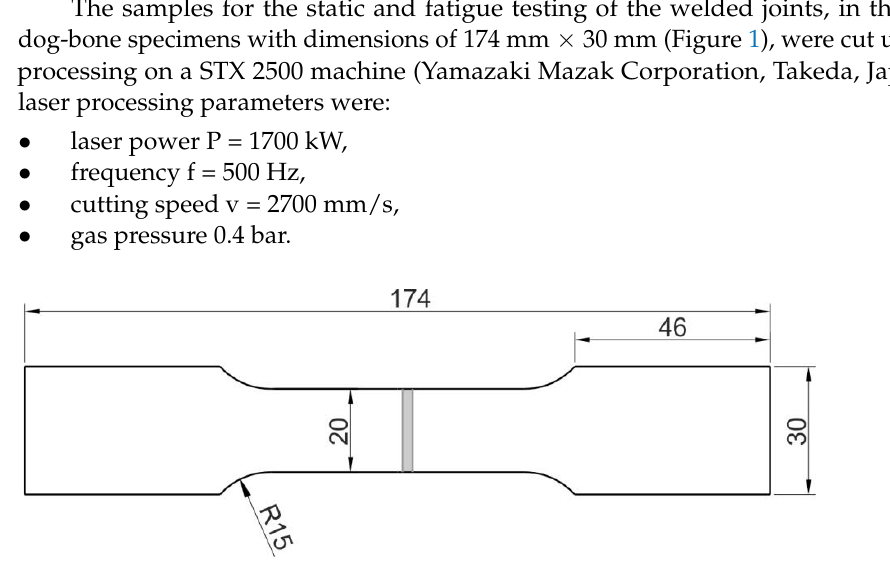
Figure 1. Dimensions (in mm) of the flash butt welded specimen for strength testing.